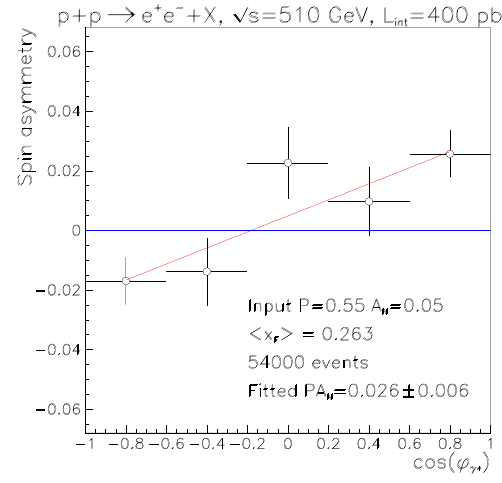
Figure 13. Projected sensitivity to A N for DY production for a forward detection system proposed for installation at STAR in 2016. M γ ∗ > 4 GeV / c 2 is imposed, but otherwise DY kinematics match those from SIDIS [35,